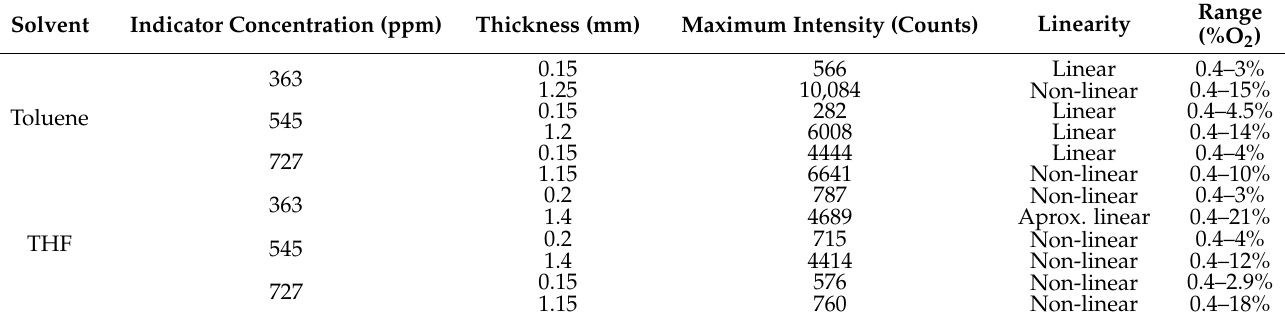
Table 2. Characterization of membranes.